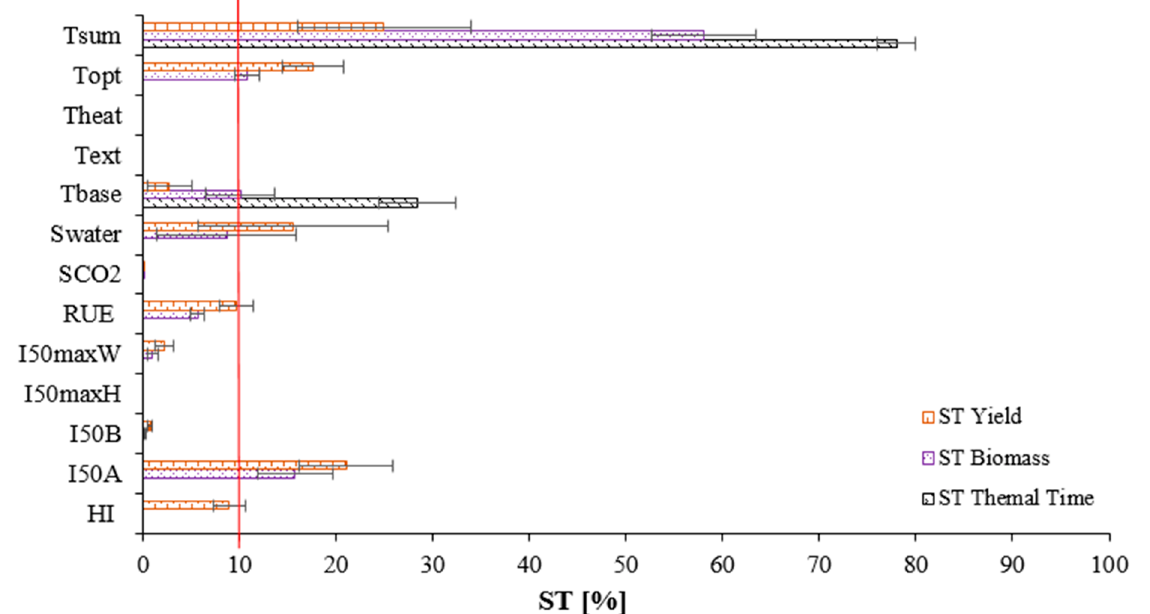
Figure 6. First order sensitivity indices (±standard deviation) with Sobol’s method for the rainfed bean crop for the variables predicted by the SIMPLE model; dashed line denotes 10% threshold.